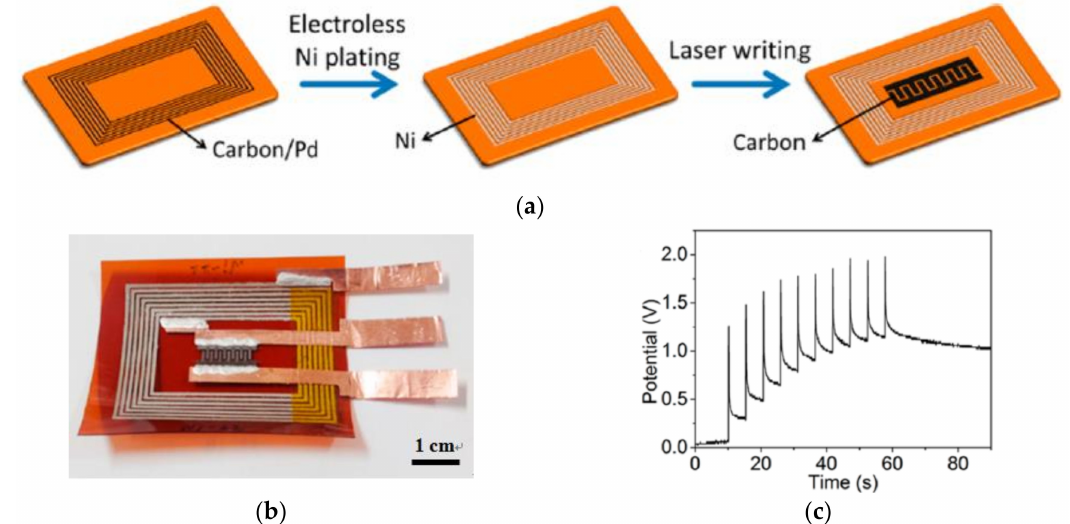
Figure 17. ( a ) Schematic representation of a device in which a carbon/Ni composite outer coil is integrated with an internal carbon MSC; ( b ) manufactured integrated wireless charging and storage device; and ( c ) the changes of the potential between two MSC electrodes as several wireless pulses are applied